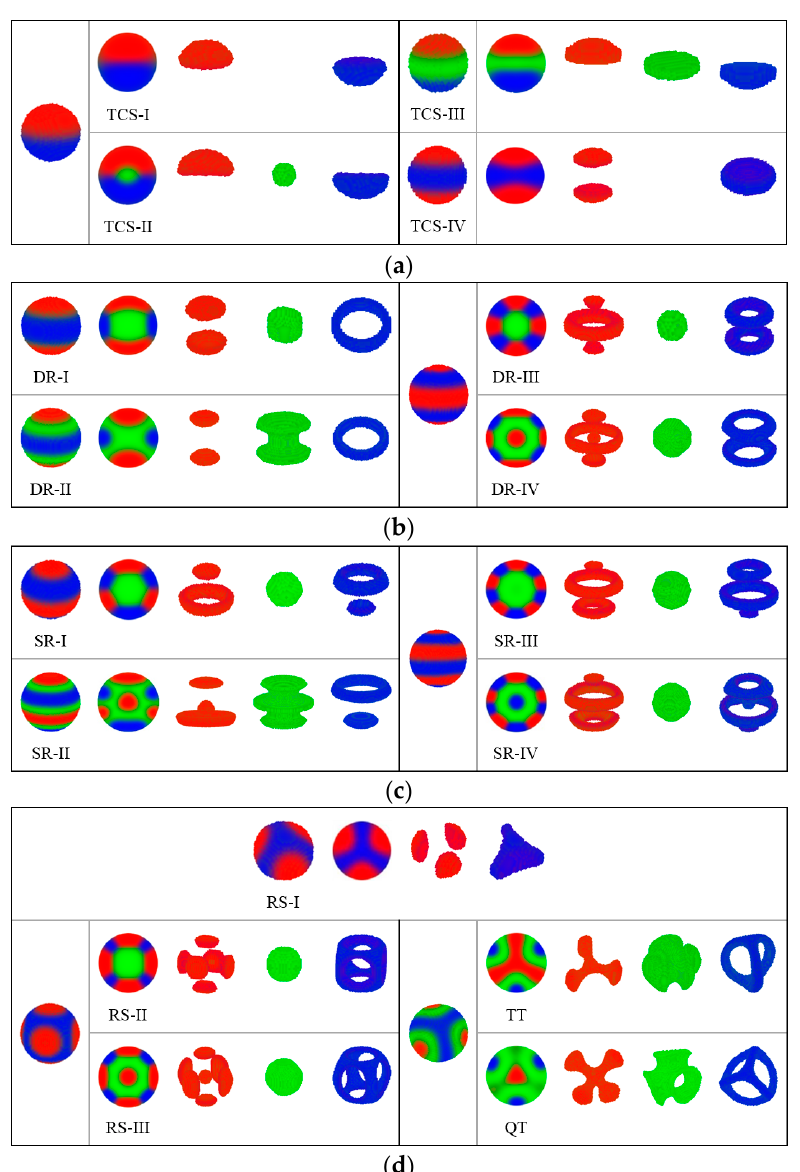
Figure 7. Self-assembled structures of ABC linear triblock copolymers in a spherical cavity of diameters, d eff = 2.60–8.60 R g . B monomers are attracted to the surface, whereas AC monomers are repelled from the surface. Red, green and blue represent the A-, B- and C-rich domains, respectively. ( a ) Two (or three)-coloured sphere (TCS) structures, ( b ) disk ring (DR) structures, ( c ) sphere-ring (SR) structures and ( d ) rotational structure (RS), treble texture (TT), and QT structures. (a): Two (or three)-coloured sphere (TCS). Four structures belong to TCS group displayed in Figure 7a. The TCS-I structure is a combination of an A-rich hemisphere and a C-rich hemisphere. In contrast to the MS structure, TCS-I is covered by a B-filled wetting layer. The TCS-II structure replicates the appearance of TCS-I with a small B-rich core that exists in the sphere centre. The core region enlarges and transforms into a disk that separates the A- and C-rich regions in the TCS-III structure. The three TCS structures are different in the B-rich region; however, these structures are homologous and follow the same formation mechanism. Li and Shi et al. observed Janus nanoparticles formed by A (cid:2876) B (cid:2876) C (cid:2876) triblock copolymer confined in small nanopores by using a simulated annealing technique [62]. The Janus nanoparticles have echoes of the formation mechanism